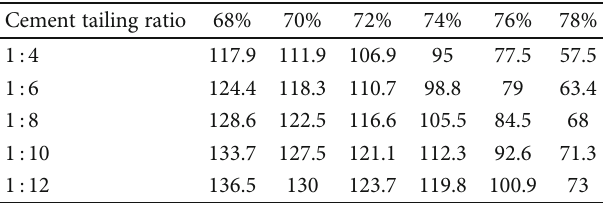
Table 5: Test results of the expansion degree of total tailing mixed slurry (unit: